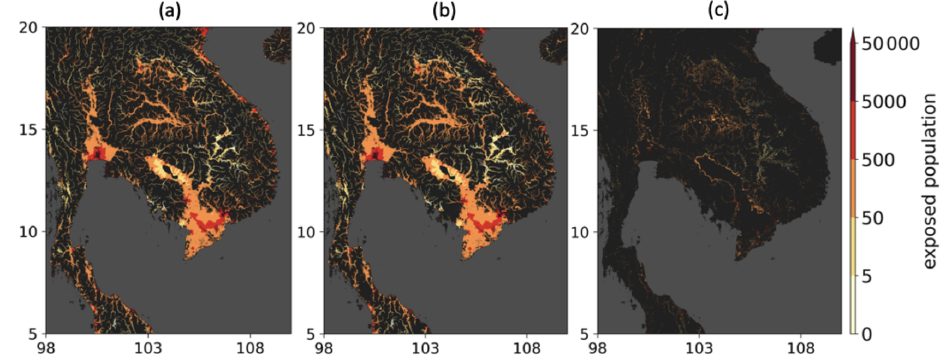
Figure 9. Affected population in the Chao Phraya River and Mekong River areas based on the 100-year RP hazard map (obtained using IPSL-CM6A-LR). (a) Reference historical-hazard map. (b) Future-hazard map constructed using the lookup method. (c) Difference of (b, a) , representing the population not currently affected by flooding that may be affected under the future